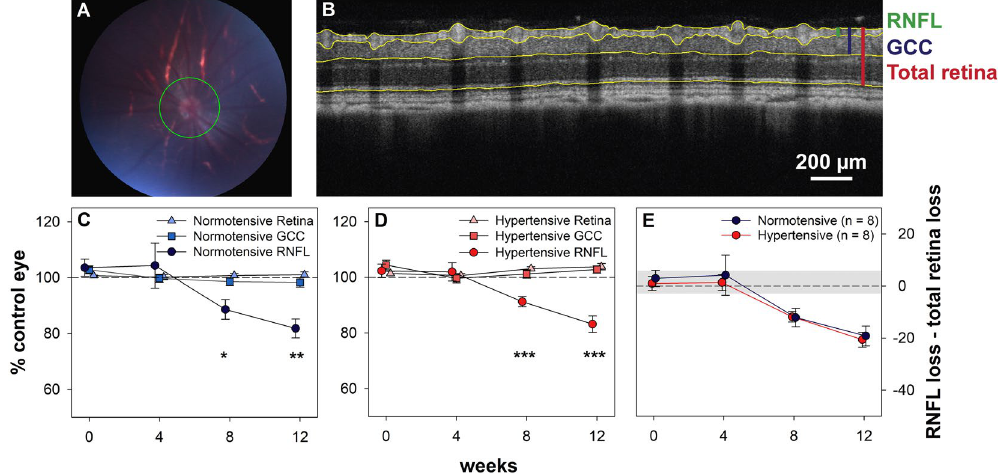
Figure 5. Effect of chronic IOP elevation on retinal layer thickness in normotensive and hypertensive rats. ( A ) Fundus image captured during OCT imaging with green reference ring indicating the position of the OCT scan. ( B ) Linear OCT B-scan (average of 20 B-scans) segmented to demarcate the vitreous interface, border of RNFL and GCL layers, border of IPL and INL layers and the junction between photoreceptor inner and outer segments. Green bar: RNFL; blue bar: GCC; red bar: total retinal thickness. ( C ) Change in retinal layer thickness (mean ± SEM, n = 8) relative to control eyes in normotensive animals. ( D ) Change in retinal layer thickness (mean ± SEM, n = 8) relative to control eyes in hypertensive animals. ( E ) Difference between RNFL change and total retinal thickness change (RNFL% − total retina%) in hypertensive and normotensive animals. The shaded region indicates the 95% confidence interval derived from all animals at baseline. (GCC: ganglion cell complex, RNFL: retinal nerve fibre layer). * Indicates p < 0.05, ** Indicates p < 0.01, *** Indicates p < 0.001 for post-hoc comparisons of change in total retinal and RNFL, and GCC and RNFL thickness at each